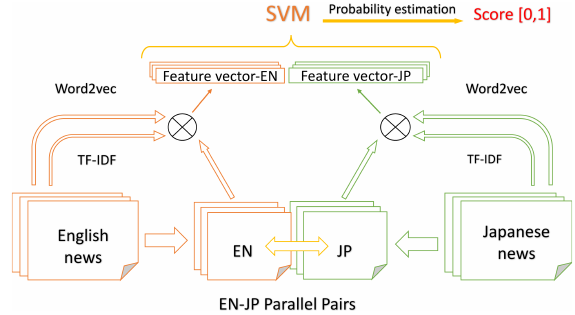
Figure 1. Illustration of our SVM-based